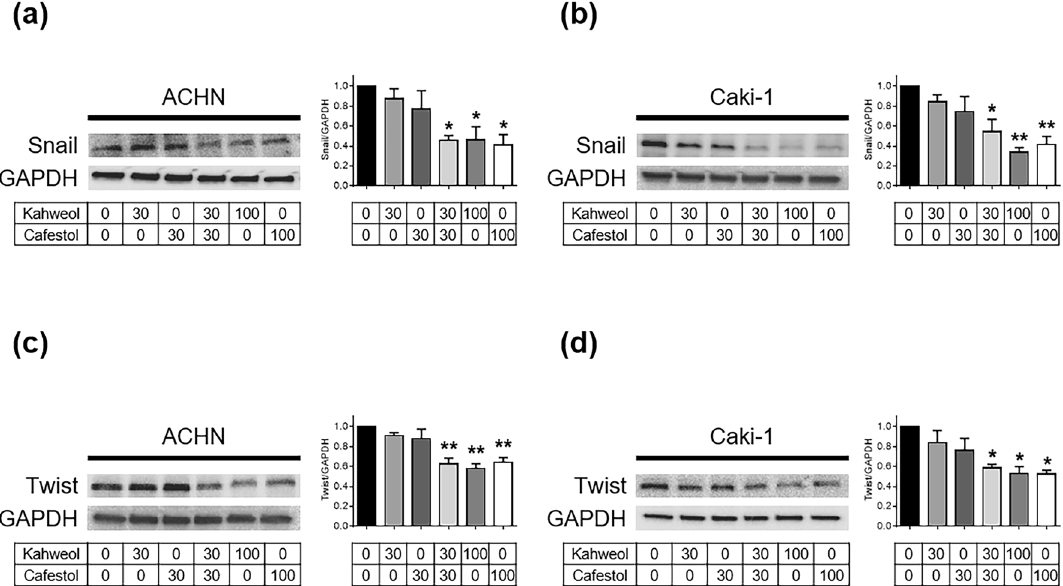
Figure 3. Kahweol acetate and cafestol treatment promoted downregulation of epithelial–mesenchymal transition (EMT)-related proteins in renal cancer cells. ( a – d ), Protein levels of EMT-associated genes, Snail in ACHN ( a ) and Caki-1 ( b ) cells, Twist in ACHN ( c ) and Caki-1 ( d ) cells, treated for 24 h were measured using Western blot analysis and quantitatively analyzed using densitometry with ImageJ software as shown by bar graphs. Soluble cell lysates (30 µg in Snail, 10 µg in Twist) were subjected to electrophoresis. Data were presented as means ± standard error of the mean (n = 4). * p < 0.05; ** p < 0.01.